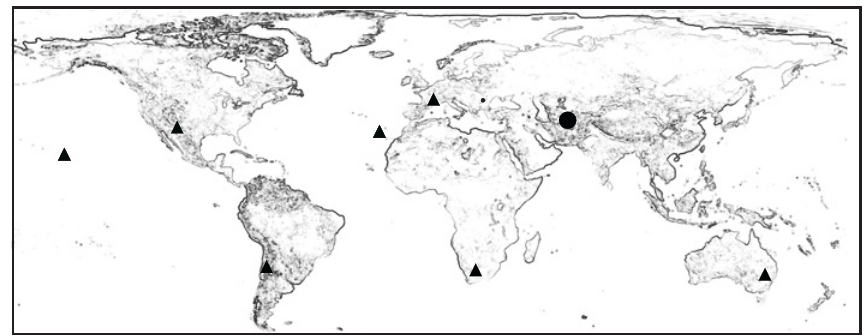
Fig. 1. Seven WET sites (black triangles) prior the offer to use the Maidanak site (black circle).